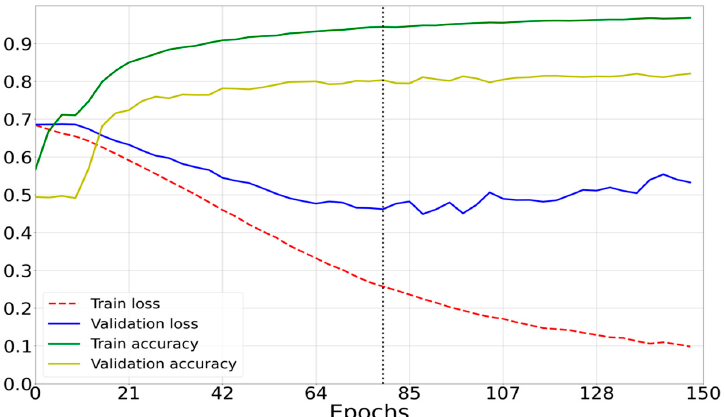
Figure 12. Loss curves of the model (Figure 9c) (green and yellow) and accuracy curves (blue and red).